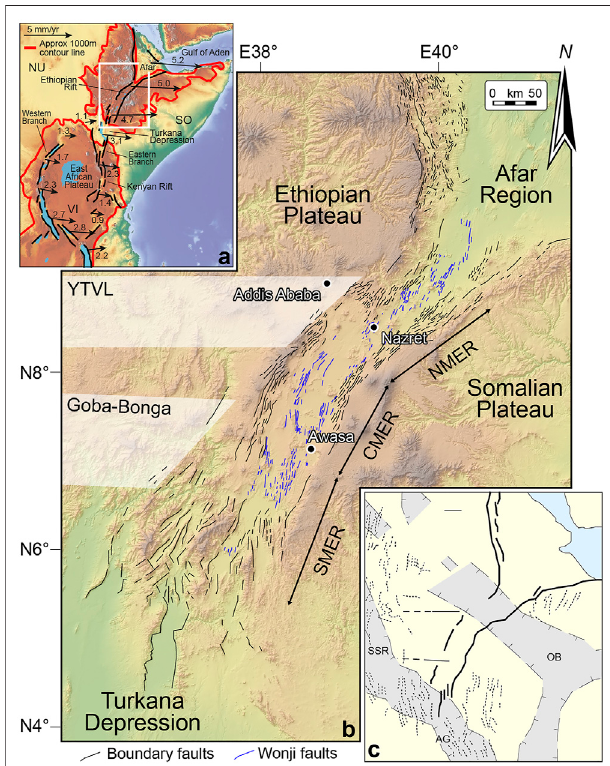
FIGURE 1 | Tectonic setting of the Main Ethiopian Rift. (A) Present-day platekinematicsoftheEastAfricanRift(modi fi edfromCortietal.,2019).Black arrows showrelativemotionswithrespecttoastableNubian reference frame; values besides arrows indicate motion in mm/yr. NU: Nubian plate; SO: Somalianplate;VI:Victoriamicroplate. (B) Mainrift-related faultsdifferentiated in Boundary and Wonji (axial) faults; indicated is the subdivision in the different segments: Northern MER (NMER), Central MER (CMER), Southern MER (SMER). Whitish pattern indicates the transversal lineaments of Yerer-Tullu Wellel (YTVL) and Goba-Bonga. (C) Inherited structures in Ethiopia (modi fi ed from Korme et al., 2004; Gani et al., 2009). Dashed lines indicate NE-SW- to N-S-trending basement foliations; solid lines illustrate E-W structures, corresponding to the main transversal lineaments affecting the rift; greyish pattern represents NW-SE-trending structures corresponding to sedimentary Mesozoic basins (AG: Anza graben; OB: Ogaden basin; SSR: South Sudan